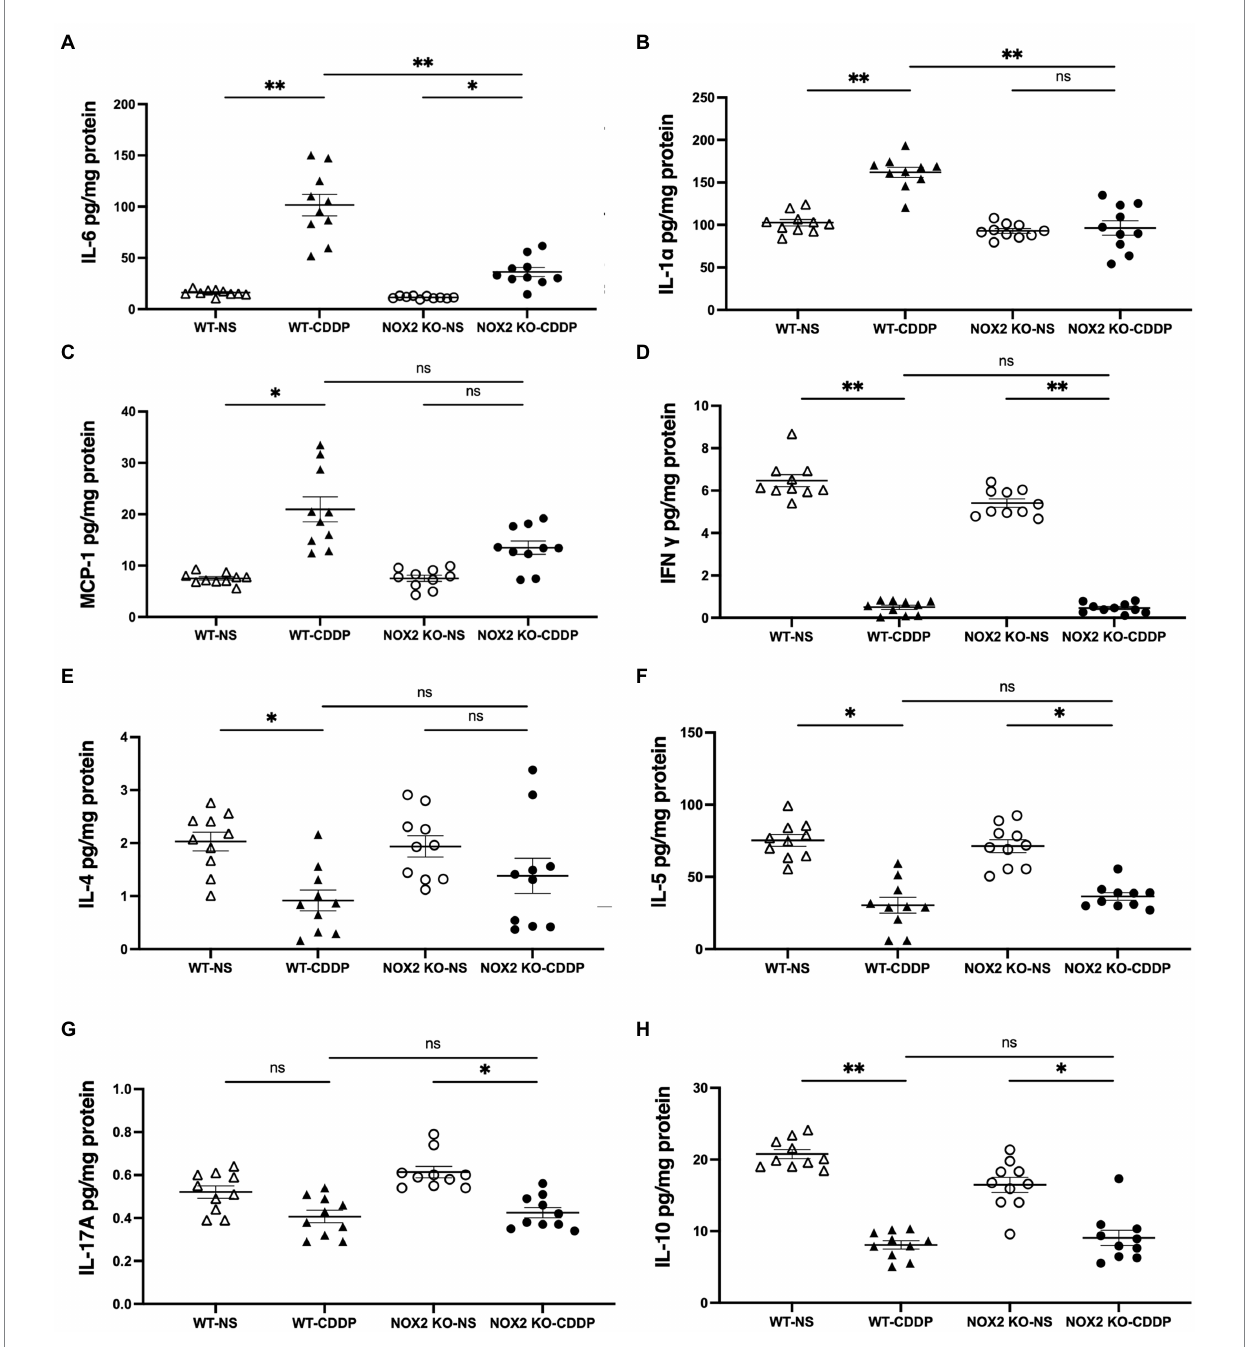
FIGURE 5 Cytokine expression with Luminex assay in cisplatin-induced AKI in the WT and NOX2-KO groups. (A,B) IL-6 and IL-1 α proinflammatory factors were significantly reduced in the NOX2 KO-CDDP group compared to the WT-CDDP group. (C–G) MCP-1 and T-helper lymphocyte cytokines such as IFN- γ , IL-4, IL-5, and IL-17A did not show significant changes between the WT-CDDP and NOX2 KO-CDDP groups. (H) IL-10 was significantly reduced in the WT-CDDP group compared with the WT-NS group. IL-10 was mildly recovered in the NOX2 KO-CDDP group compared with the WT-CDDP group. Data represent the mean ± standard error of five mice per group. The experiment was repeated twice with similar results.